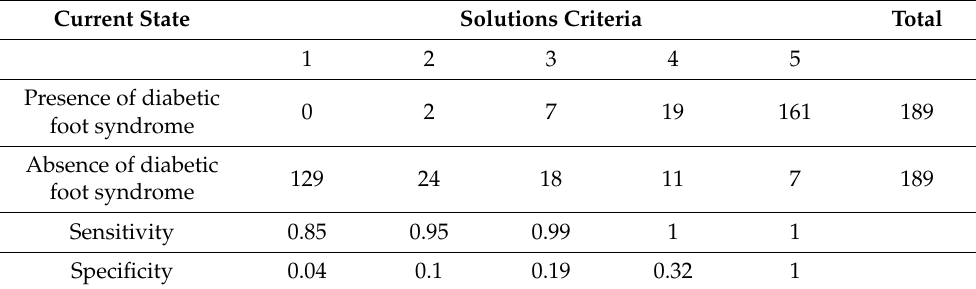
Table 3. Evaluation of the effectiveness of the proposed classification of the diabetic foot syndrome to reflect the presence of the diabetic foot syndrome in the patient’s